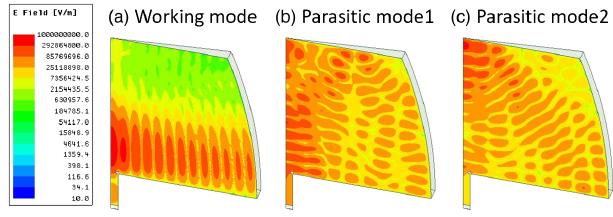
FIG. 12. Electrical field of the working mode and the parasitic modes in the storage cavity. 8 degree slice model of the cavity with a storage energy of 1 J was simulated by the eigenmode solver of HFSS. The electrical fields are in logarithmic scale. is cav (a) is the working mode at 11.994 GHz. (b) and (c) are the parasitic